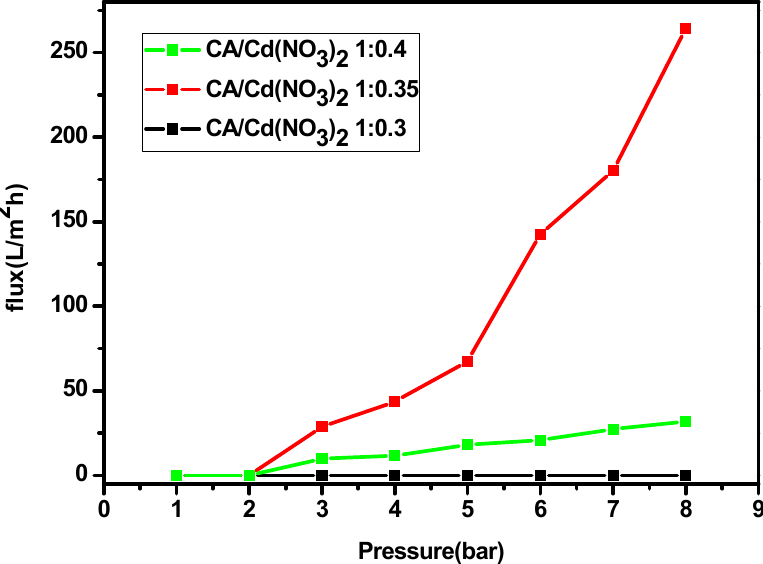
Figure 2. Flux measured through neat CA and CA with Cd(NO 3 ) 2 · 4H 2 O at various water pressures.